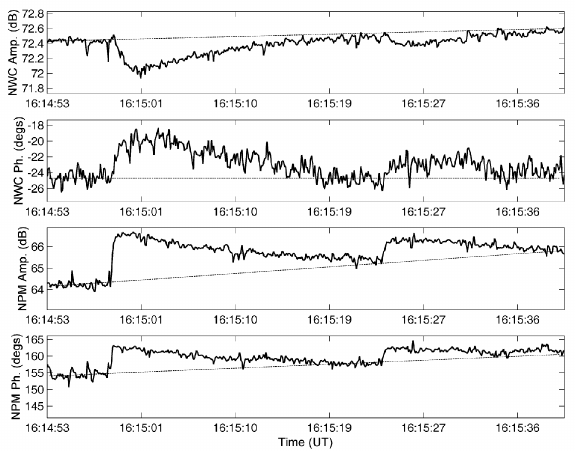
Fig. 4. An example of a fairly large Trimpi event observed on trans- missions from NWC and NPM at Dunedin on 1 November 2003. The time resolution is 0.4s. The unperturbed behaviour of the sig- nals is indicated by the long dashed